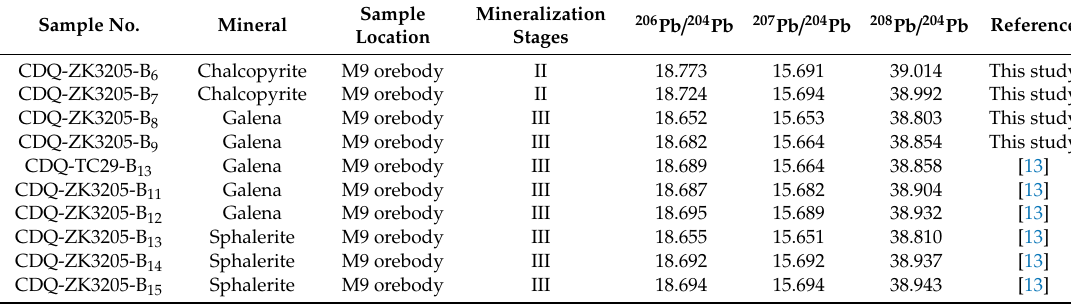
Table 6. Lead compositions of the Chuduoqu Pb-Zn-Cu